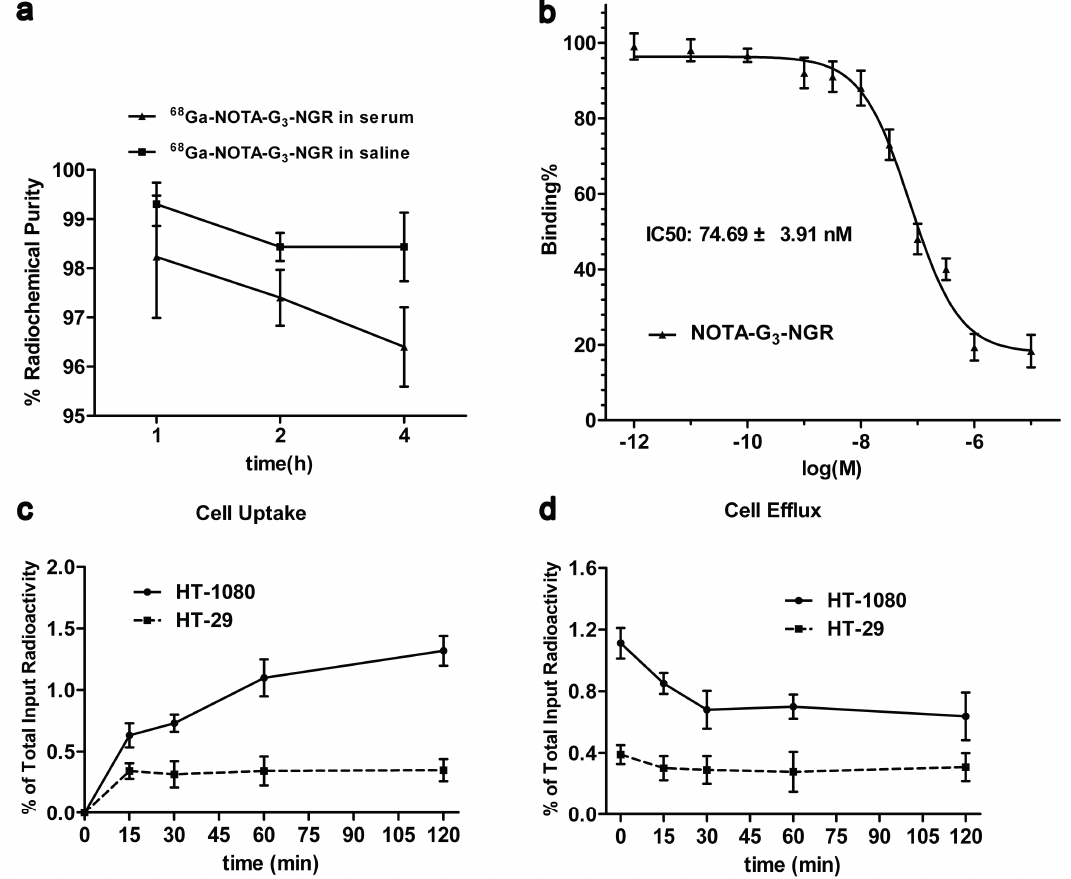
Figure 1. ( a ) In vitro stability of 68 Ga-NOTA-G in human serum at 37 °C for 1, 2, and 4 h; ( b ) In vitro inhibition of 125 I-NGR binding to CD13 receptor by NOTA-G was calculated to be 74.69 ± 3.91 nM ( n = 3); ( c ) Cell uptake of 68 Ga-NOTA-G HT-1080 and HT-29 cells ( n = 3, mean ± SD); ( d ) Cell efflux of 68 Ga-NOTA-G HT-1080 and HT-29 cells ( n = 3, mean ±